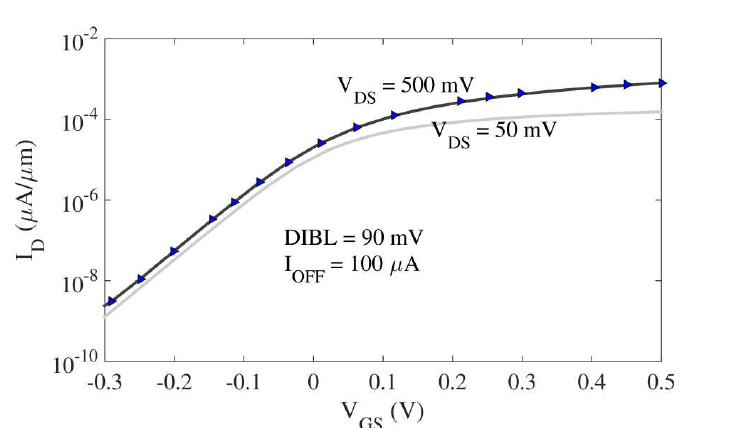
Figure 2. Calibration of the transfer characteristics of device with W f = 22 nm and L g = 30 nm with the experimental data (blue symbol graph)